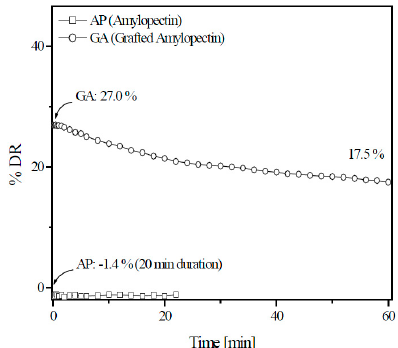
Figure 11. Percentage drag reduction versus time for amylopectin and its derivative (GA) at 25 °C, 1740 rpm ( N Re = 1.0 × 10 6 ), and 30 wppm, reprinted with permission from [87]. Copyright De Gruyter, 2013.